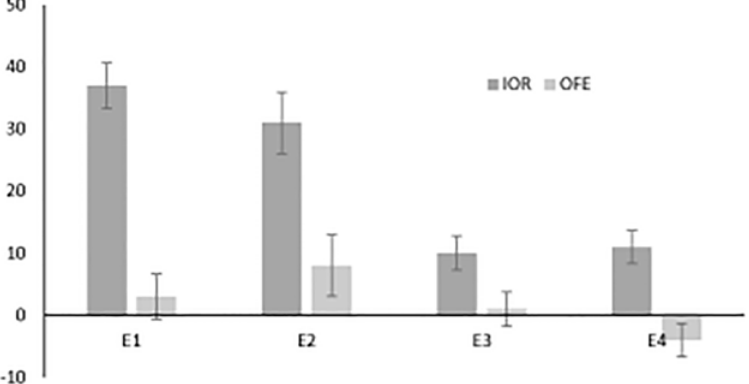
Fig 4. Results from all four experiments. IOR = cued minus orthogonal (+/-90°); OFE = orthogonal (+/-90°) minus uncued (see Fig